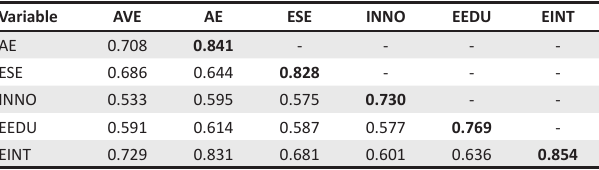
TABLE 4: Correlation coefficient and average variance extracted. Variable